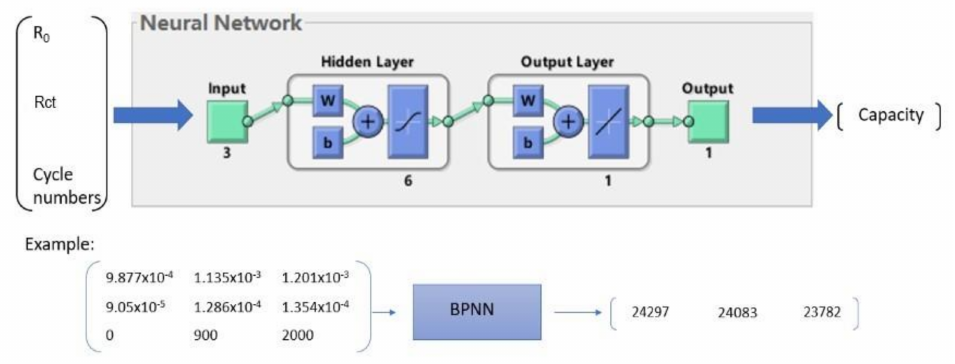
Figure 9. Structure of the backpropagation neural